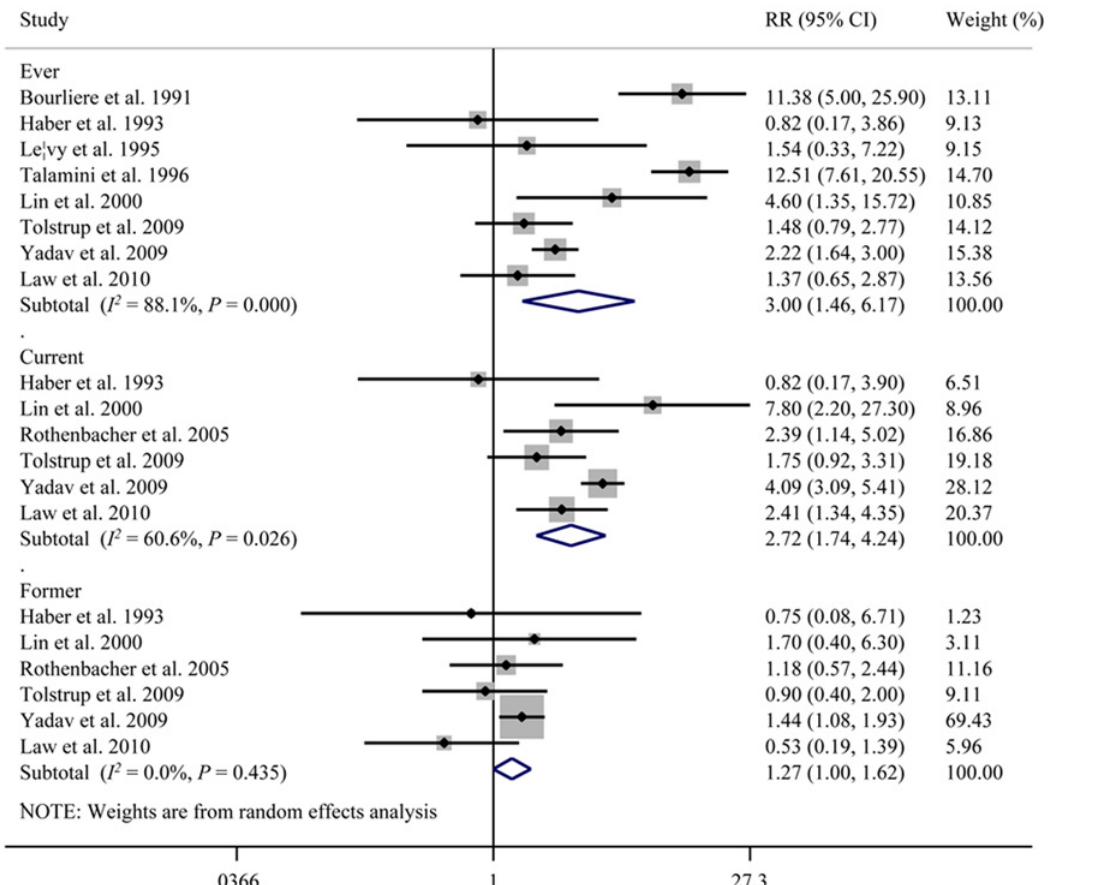
Fig 3. Cigarette smoking and the risk of chronic pancreatitis. CI, confidence interval; RR, relative risk.